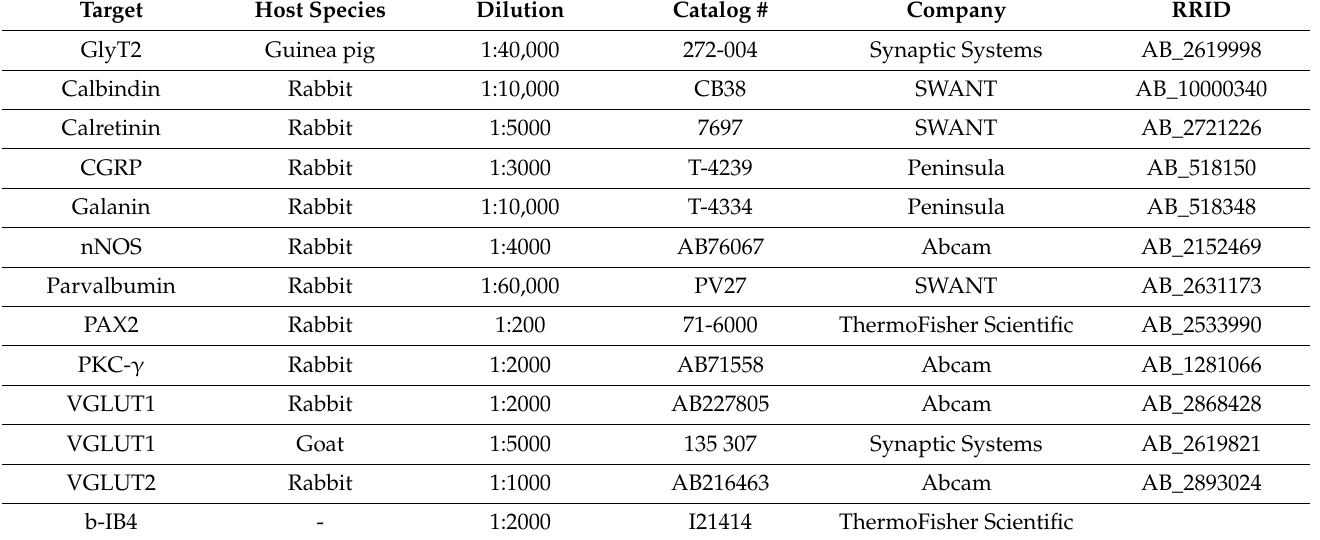
Table 3. List of primary antibodies